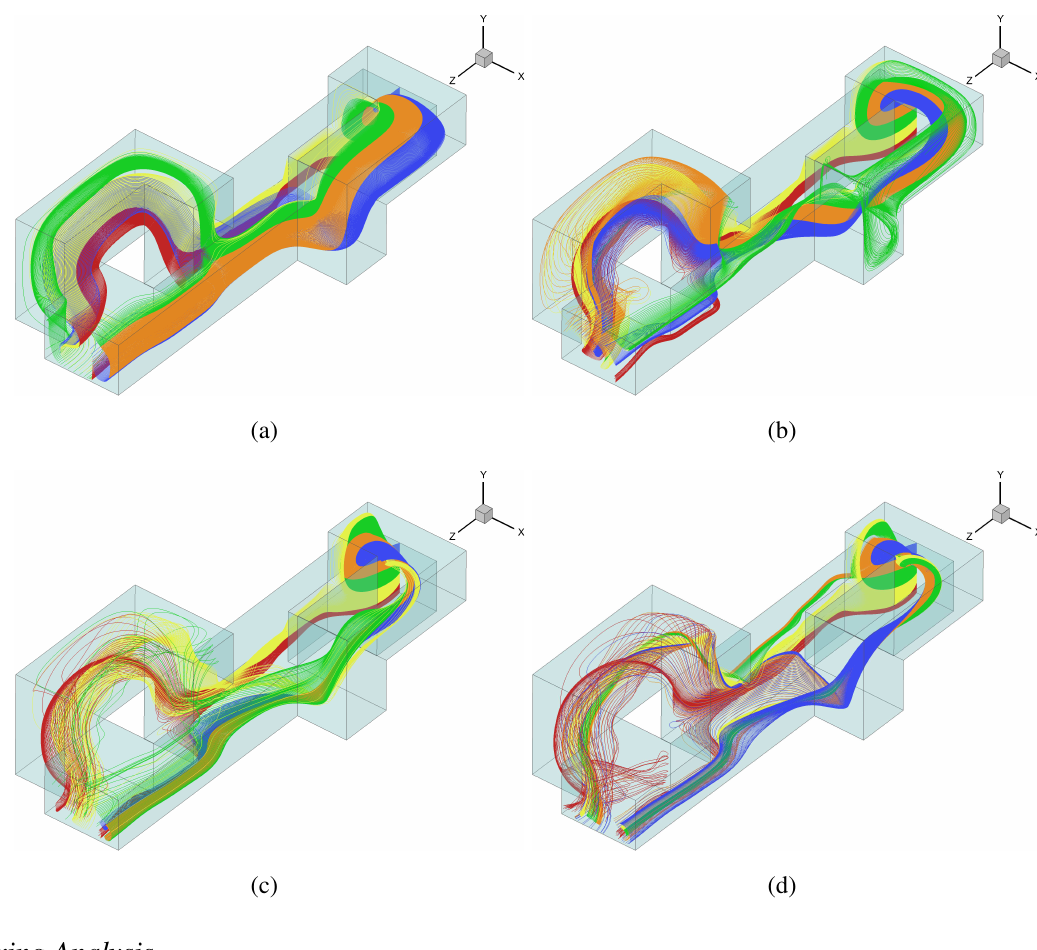
Figure 6. Deformation of the interface between two fluids in the mixer with α = 1 at the four Reynolds numbers, ( a ) Re = 10 , ( b ) Re = 30 , ( c ) Re = 50 and ( d ) Re = 70